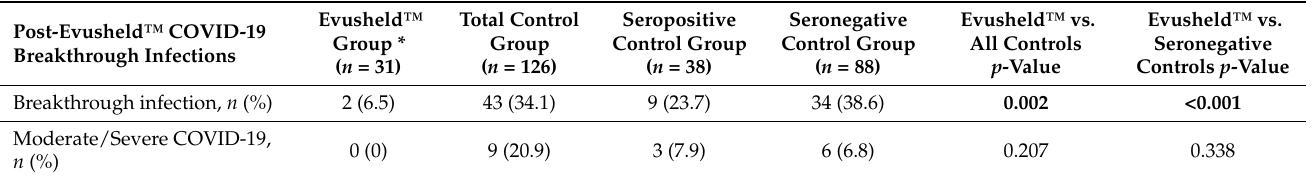
Table 2. The effectiveness of tixagevimab and cilgavimab in preventing COVID-19 breakthrough infections and decreasing their severity in